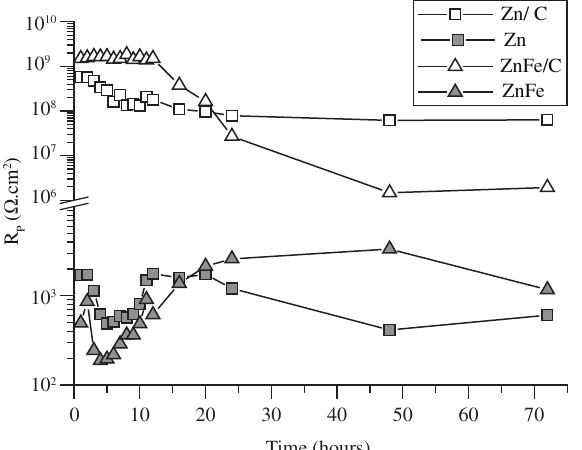
Figure 7. Potentiodynamic polarization curves of coated and uncoated